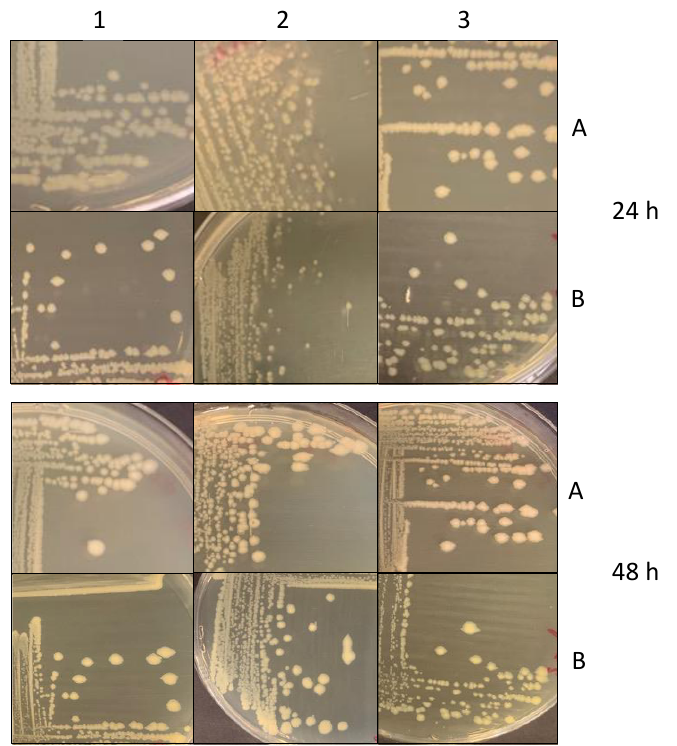
Figure 6. Morphology of bacterial colonies produced by serum-sensitive (SS) and serum-resistant (SR) strains. ( A ) Salmonella strains not passaged in SPPP, ( B ) Salmonella strains passaged eight times in 50% SPPP; 1 — S. Erlangen, 2 — S. Hammonia, 3 — S . Typhimurium ATCC 14028.